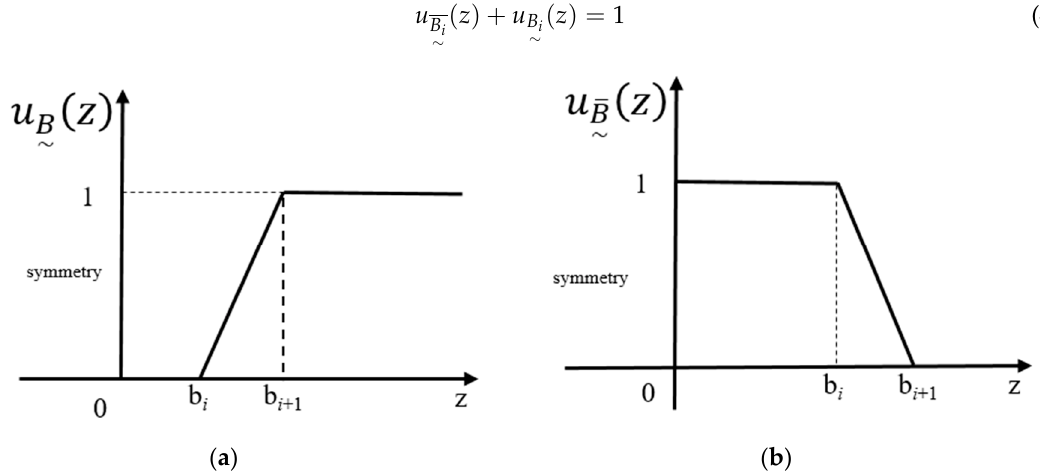
Table 7. Division of the degree of damage to pipelines.